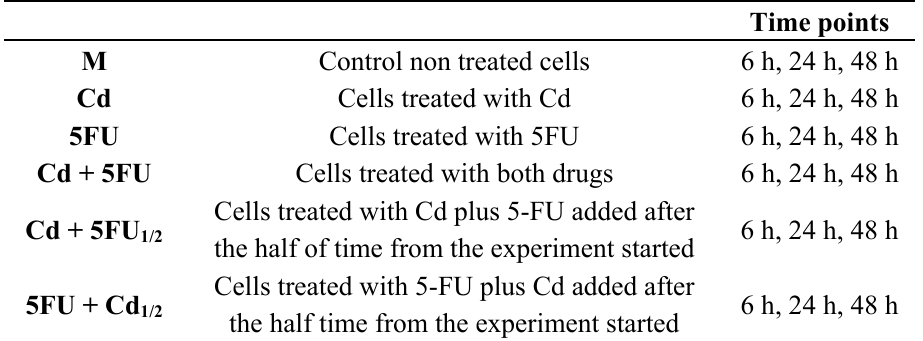
Table 2. MCF-7 experimental